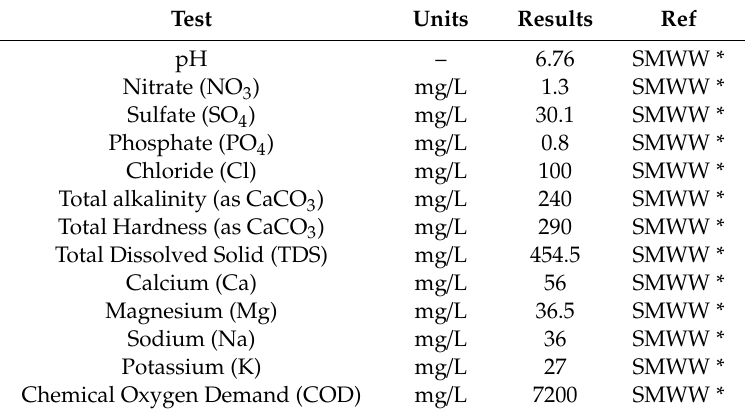
Figure 1. Capture of the site. Table 1. Sample testing results (* SMWW: Standard Method of Water and Waste water).